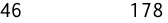
Table 1. Number of façades and image pairs considered in this study.